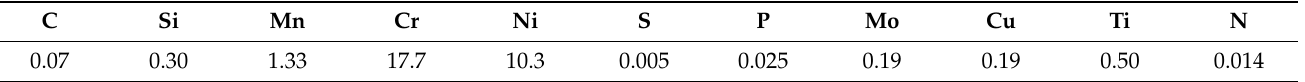
Table 1. Chemical composition (wt.%) of the AISI 321